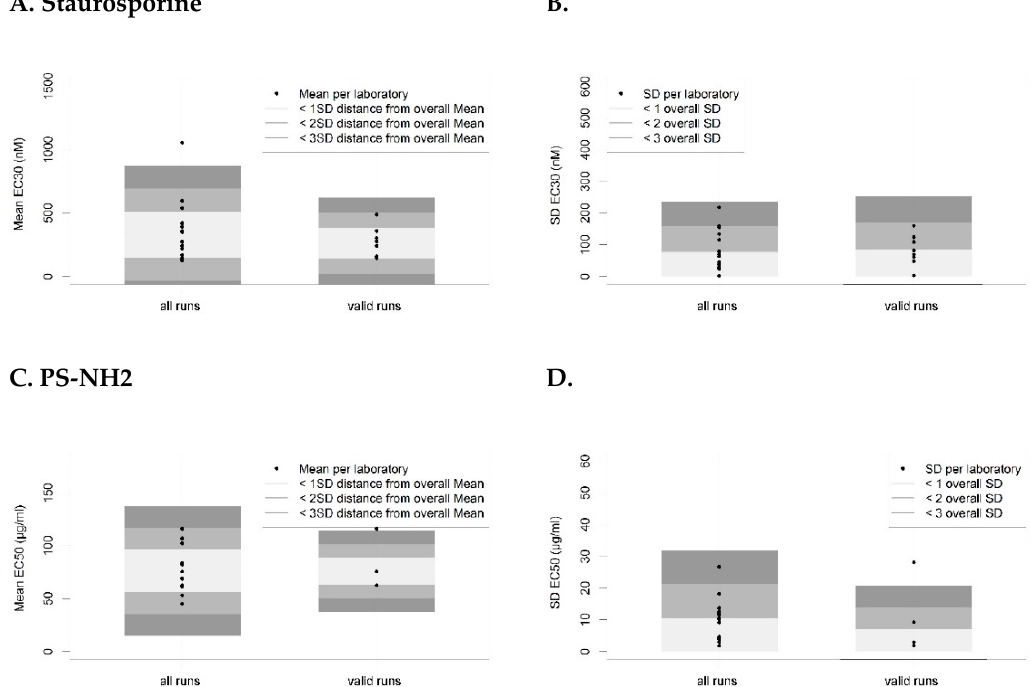
Figure 3. Intra- and inter-laboratory biases for e ff ective concentration causing 30% inhibition of cell viability (EC30) and e ff ective concentration causing 50% inhibition of cell viability (EC50) values determined using the MTS assay (tier 2). Mean values for EC30 and EC50 per laboratory compared to the overall mean and SD (left panels), as well as SD of EC30 and EC50 values per laboratory compared to the overall SD* (right panels) are shown for ( A , B ) staurosporine (N = 15 for all runs, N = 8 for valid runs) and ( C , D ) PS-NH2 (N = 15 for all runs, N = 4 for valid runs). Horizontal bars (left panel) indicate overall mean values of percentage cell survival, while grey shaded areas indicate the distances from the overall mean corresponding to 1-, 2- or 3-fold of the overall SD (left panels) or SD* (right panels).